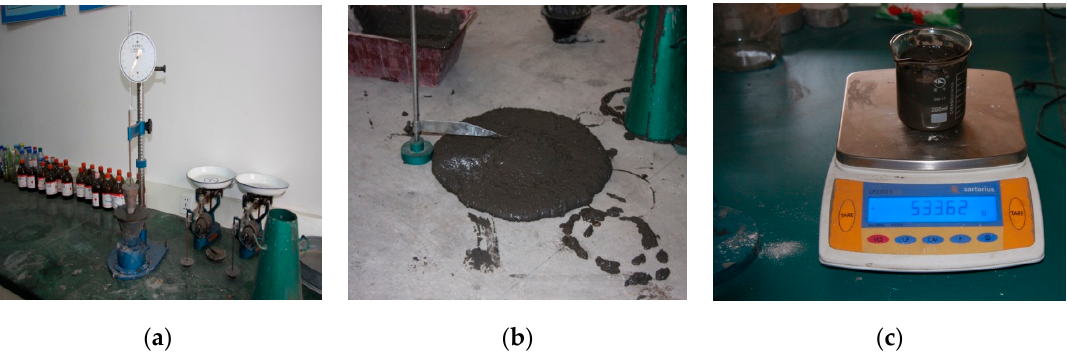
Figure 4. Hydraulic-geotechnical property tests of CPB: ( a ) Segregation test; ( b ) Slump test; ( c ) Water bleeding test.